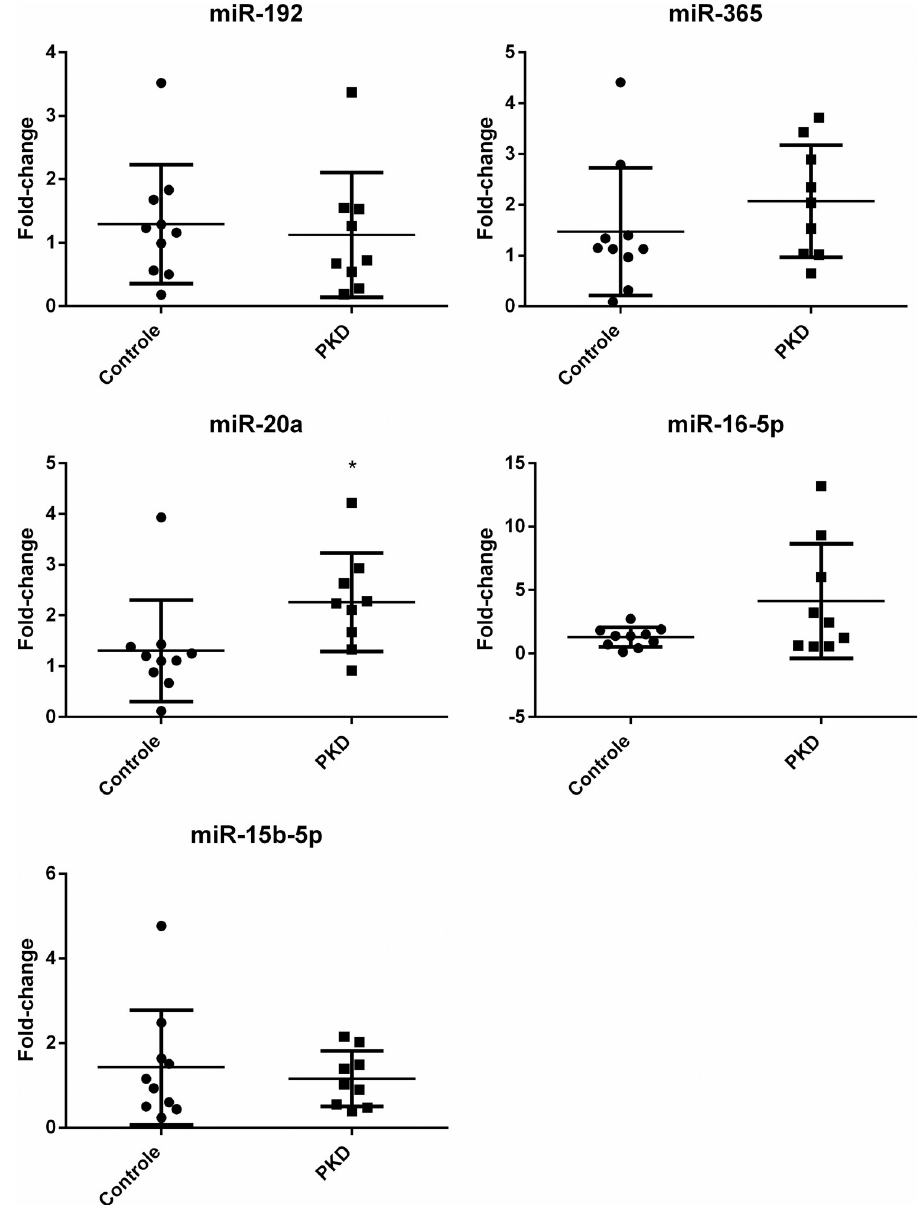
Fig 2. Fold change of serum microRNAs (miR-20a, miR-192, miR-365, miR-16-5p, miR-15b-5p) from domestic cat. RT-rtPCR assays. Normalized with cel-miR-39-3p. miR-20a is upregulated in PKD group � (p < 0.005), all the others p values were p >